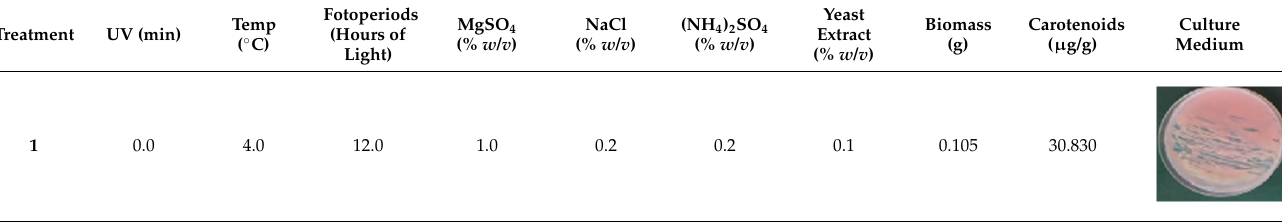
Table 1. Screening generated by the experimental design Plackett Burman.